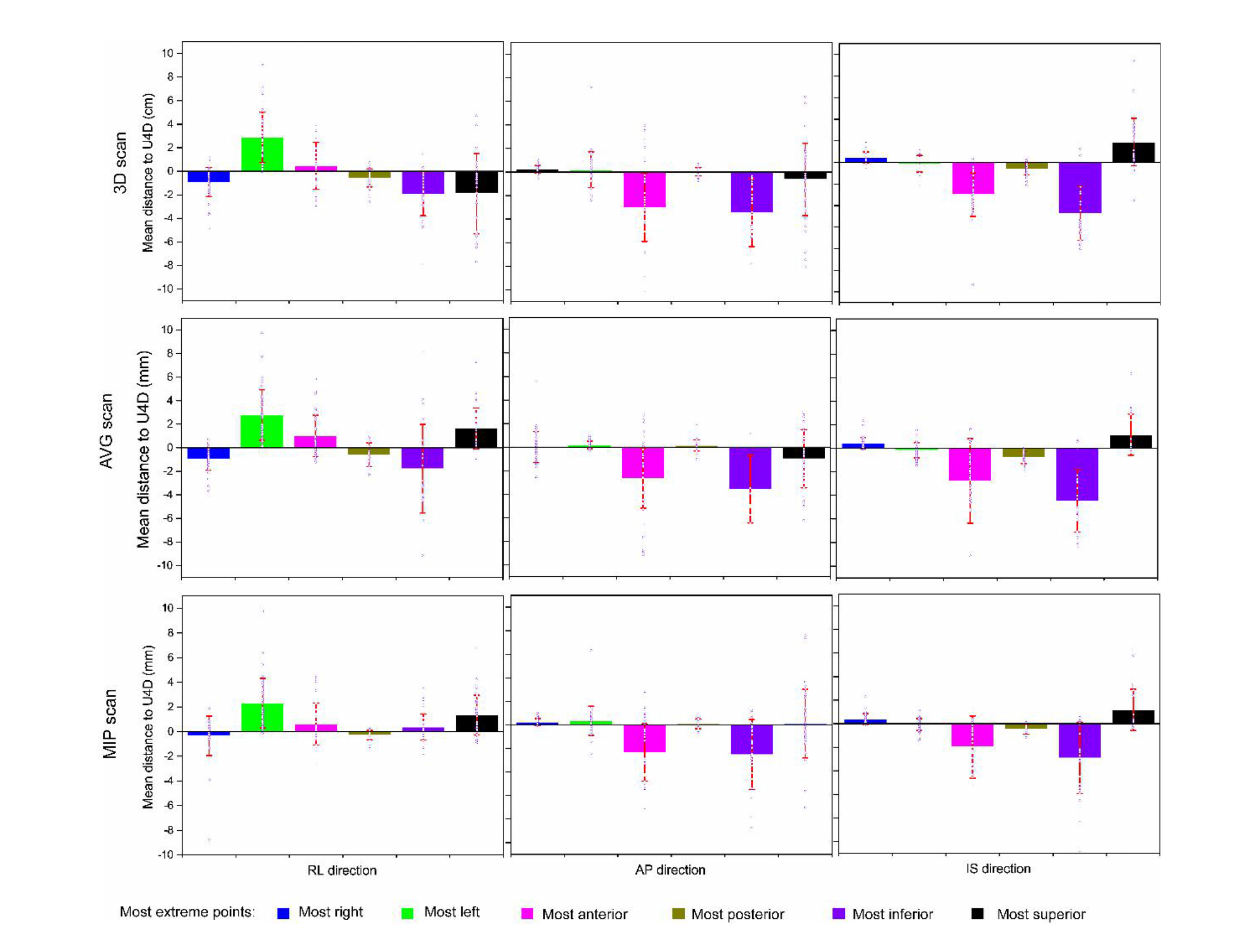
FIGURE 3 | Mean distances to the full extent of motion (U4D) for the delineations on the 3-dimensional, average projection, and maximum intensity projection scans (rows). The columns report the distance components: the right-left (RL), anteroposterior (AP), and anterosuperior (IS). The square marker represents the mean of means (M); the error bar represents standard deviation (i.e., S ). The blue hollow dots represent the individual mean distances per